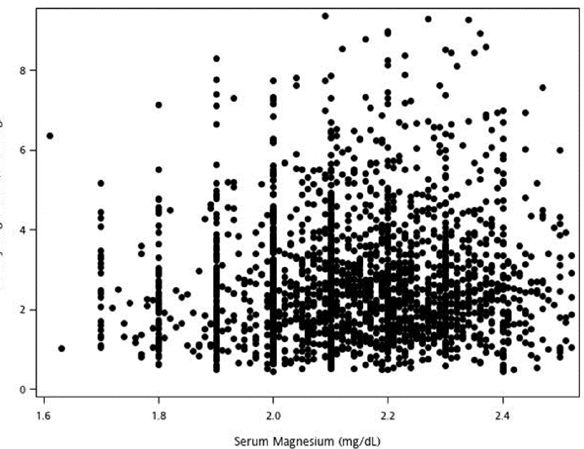
Figure 1. Scatter plot of dietary magnesium versus serum magnesium (correlation: r = 0.073, p value ≤ 0.001).